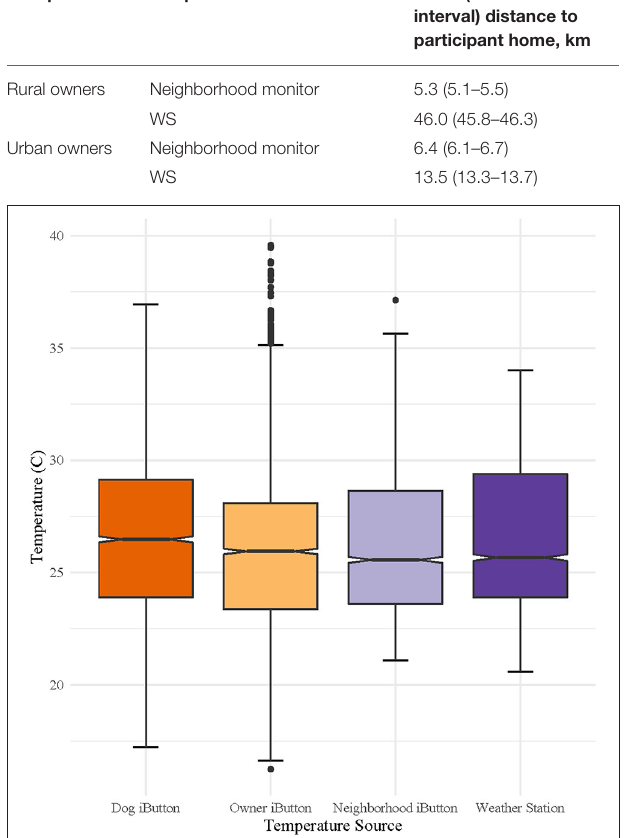
and the nearest WS. Group